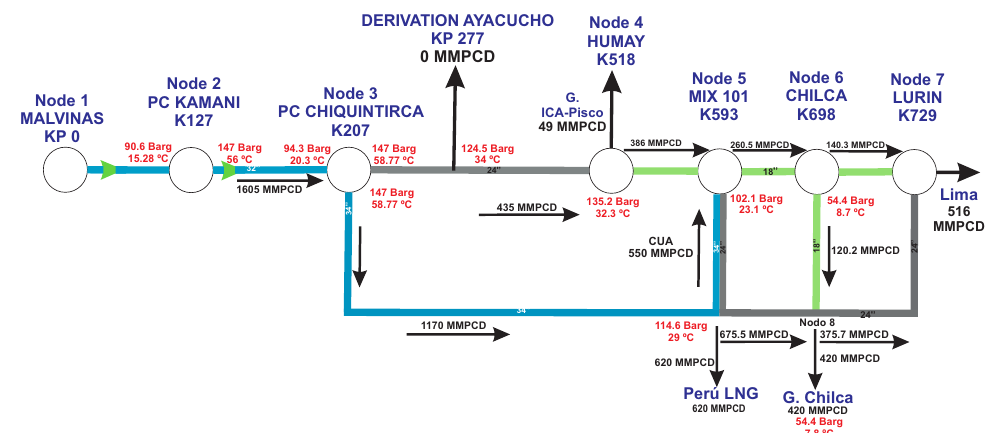
Figure 4. Diagram of the transportation capacity of the Peruvian gas pipeline (adapted from